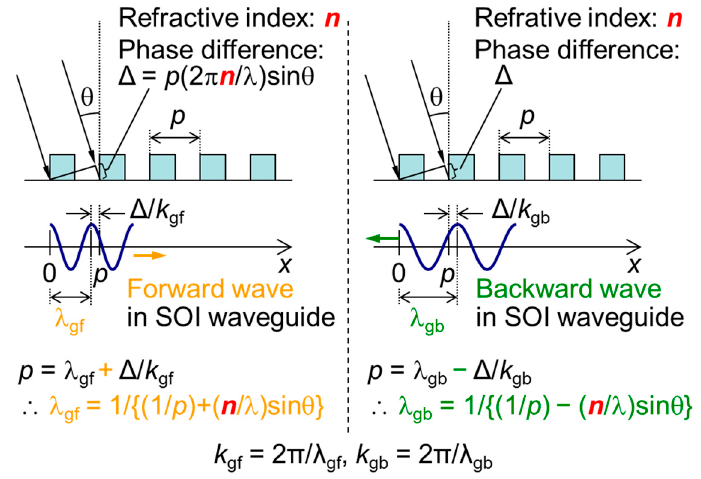
Figure 4. Schematic diagrams of phase-matching conditions between diffracted lights and forward and backward waves in the silicon-on-insulator (SOI) waveguide. n is refractive index (RI) of the incident side region. k gf and k gb are wavenumbers of the forward and backward waves, respectively. λ λ gf and gb are propagation wavelengths of the forward and backward waves,